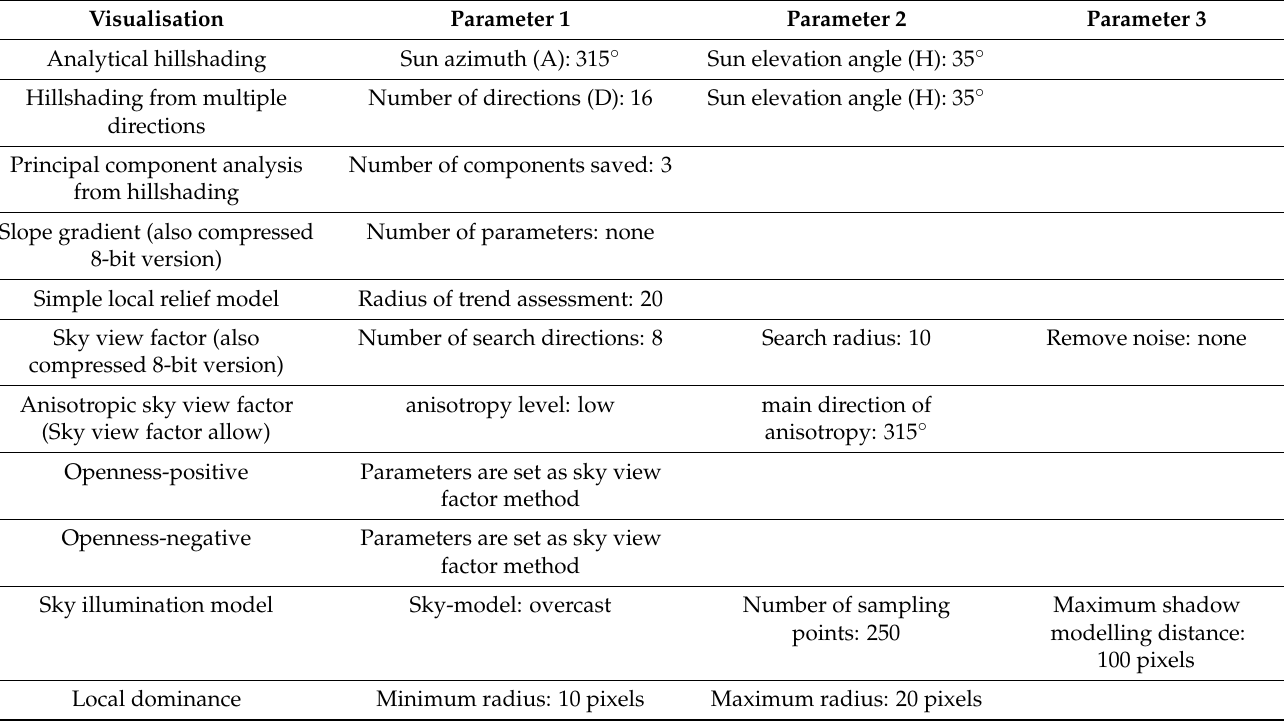
Table 1. Parameters set for each visualisation type in accordance with the RVT default setting